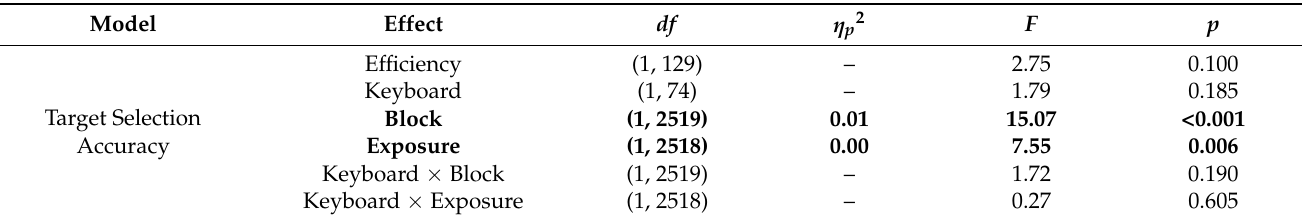
Table 1. Linear mixed-effects models for outcome measures comparing generically optimized and personalized keyboards.